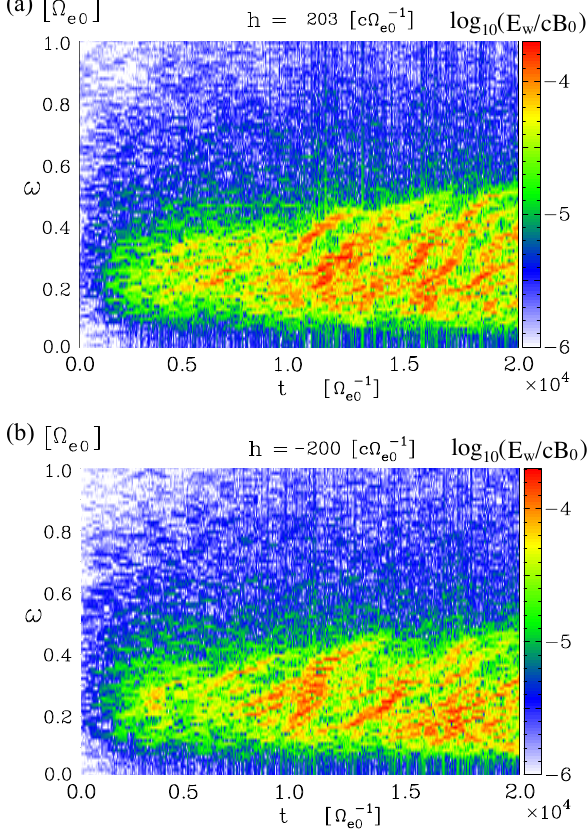
Fig. 2. Spectrograms generated in the Northern Hemisphere (top) and the Southern Hemisphere (bottom). The vertical axis represents wave frequency ω ; (cid:127) e 0 is the electron gyrofrequency at the equa- tor. Several chorus emissions are generated in both hemispheres in the simulation. These waves propagate in the poleward directions and interact nonlinearly with counter-streaming energetic electrons. The majority of the resonant electrons are untrapped and lose en- ergy slightly, thereby contributing to chorus wave generation. Se- lected electrons are trapped by the generated chorus and undergo dramatic acceleration by the RTA/URA processes.